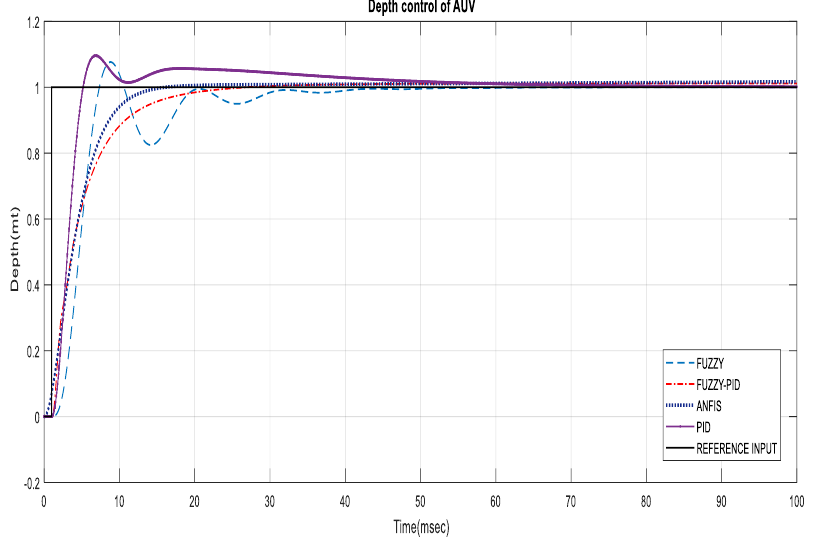
Figure 20. Time-response curve of depth plane control by FLC, PID, fuzzy-PID, and ANFIS control techniques. Table 6. Time-response characteristics comparison of depth control.